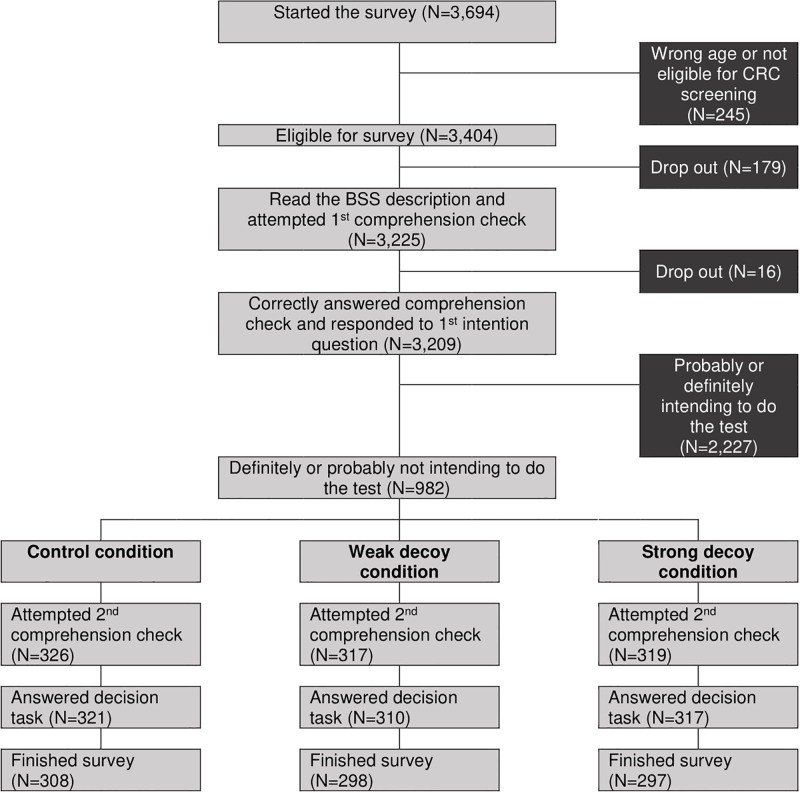
Flow though Study 2.